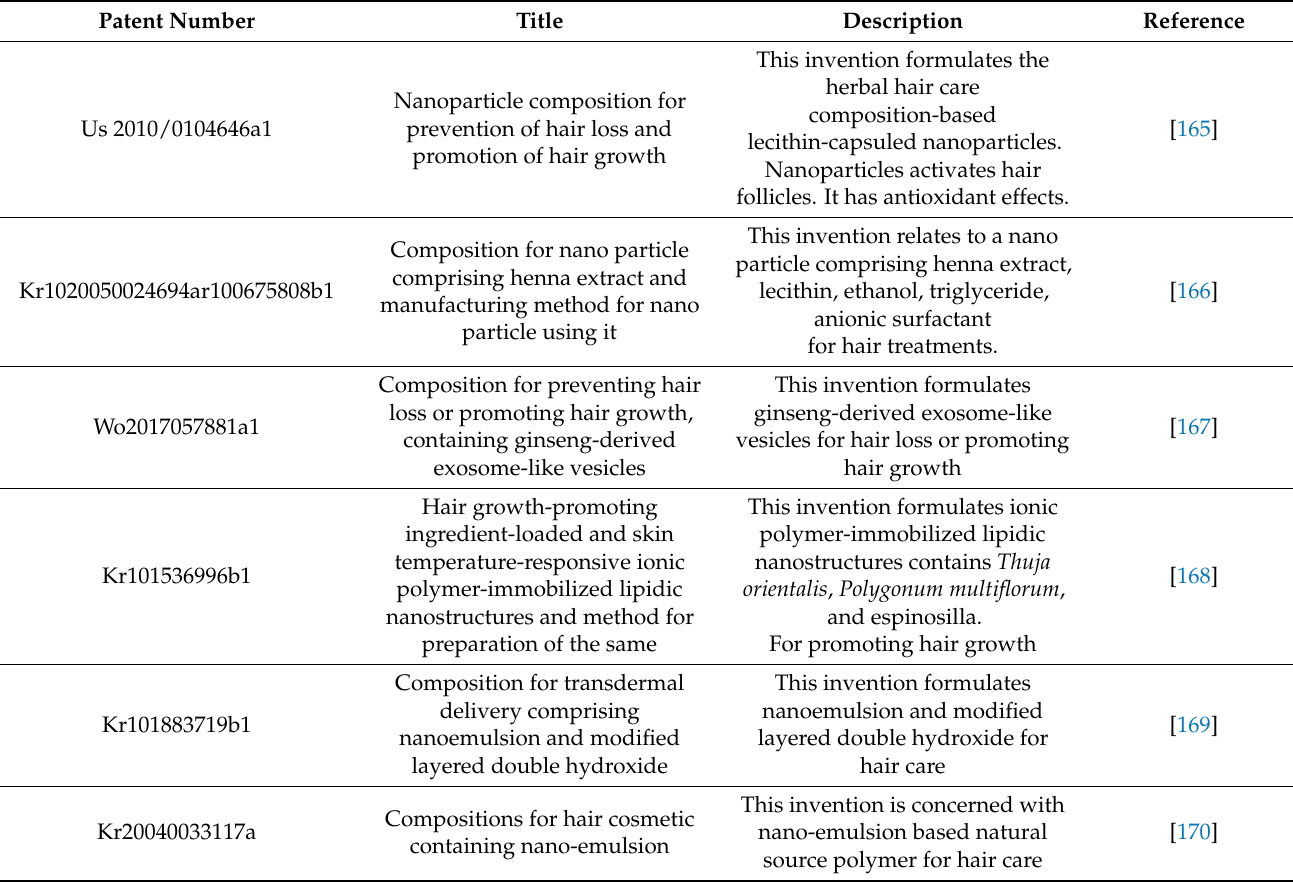
Table 8. Patents for herbal extract-based